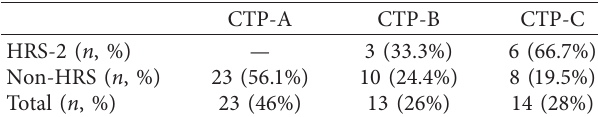
Table 3: Clinical and biological features of